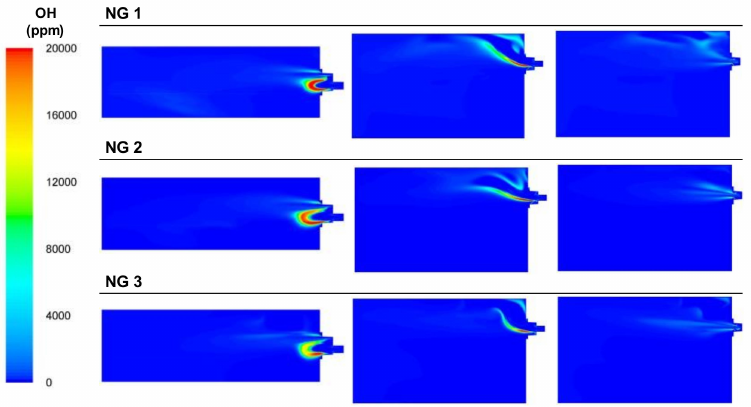
Figure 25. Contour plots of OH concentrations for the NG cases in the XZ1, XY1, and XY2 planes. The oxygen concentrations of the cases are shown in Figure 26. The oxygen calculated at the outlet port followed the experimental trend since the air flow was maintained and the oxygen flow decreased from NG 1 to NG 3. The absence of oxygen led to incomplete combustion in the NG 2 and NG 3 cases; thus, the CO concentrations increased (see Figure 27).